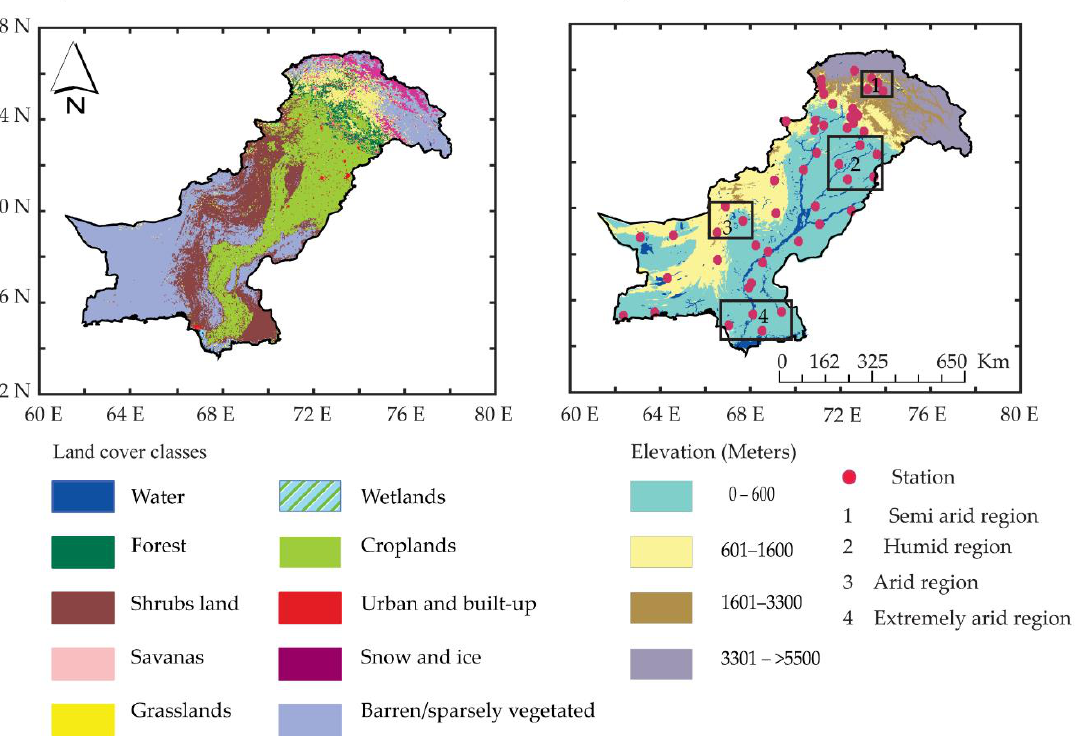
Figure 1. Land cover classes ( a ), topography, major rivers and station density of the study area ( b ). The study regions are shown in the black boxes (b), which are selected to represent differing categories of climate, elevation and land cover (Table 1). Table 1. Description of the regional elevation, climate class and land cover of the four regions selected for comparison of GPPs and in-situ observations as shown in Figure 1b.